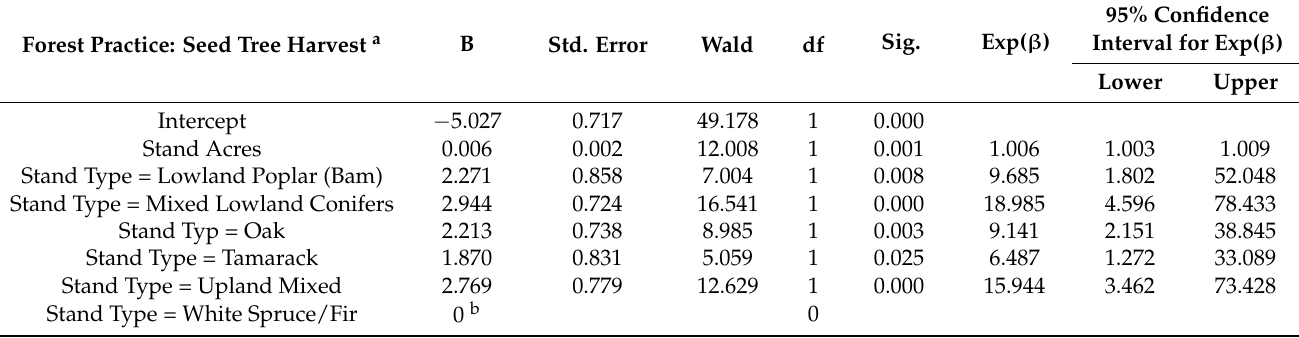
Table 5. Multinomial logistic regression parameter estimates for significant results predicting “Seed Tree Harvest.” Stand acres and stand type as independent variables (showing results from seed tree harvest). N = 20,915 unique forest stands enrolled in the Qualified Forest